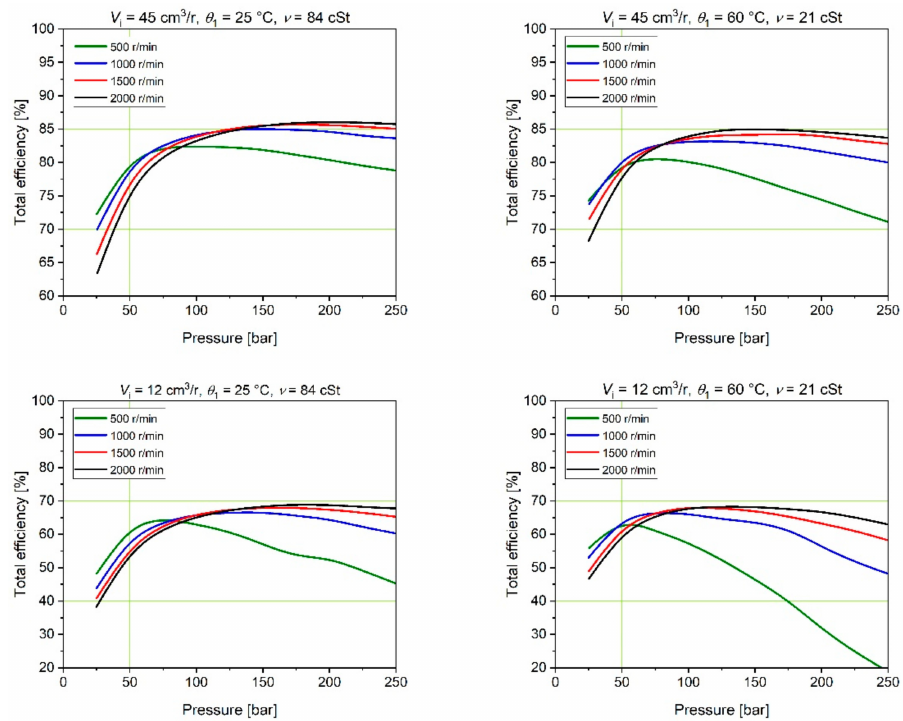
Figure 7. Total efficiency of an axial piston pump as a function of pressure with four constant rotational speeds. The ten-calculation-point efficiency curves have been smoothed with B-splines. Note the varying efficiency